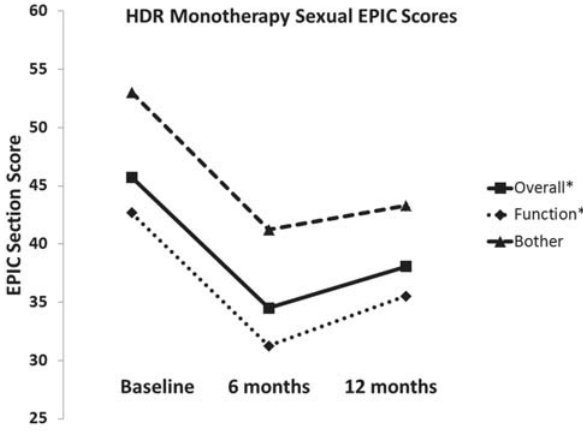
Figure 3 - EPIC sexual overall, function, and bother scores before HDR brachytherapy monotherapy and 6 and 12 months after